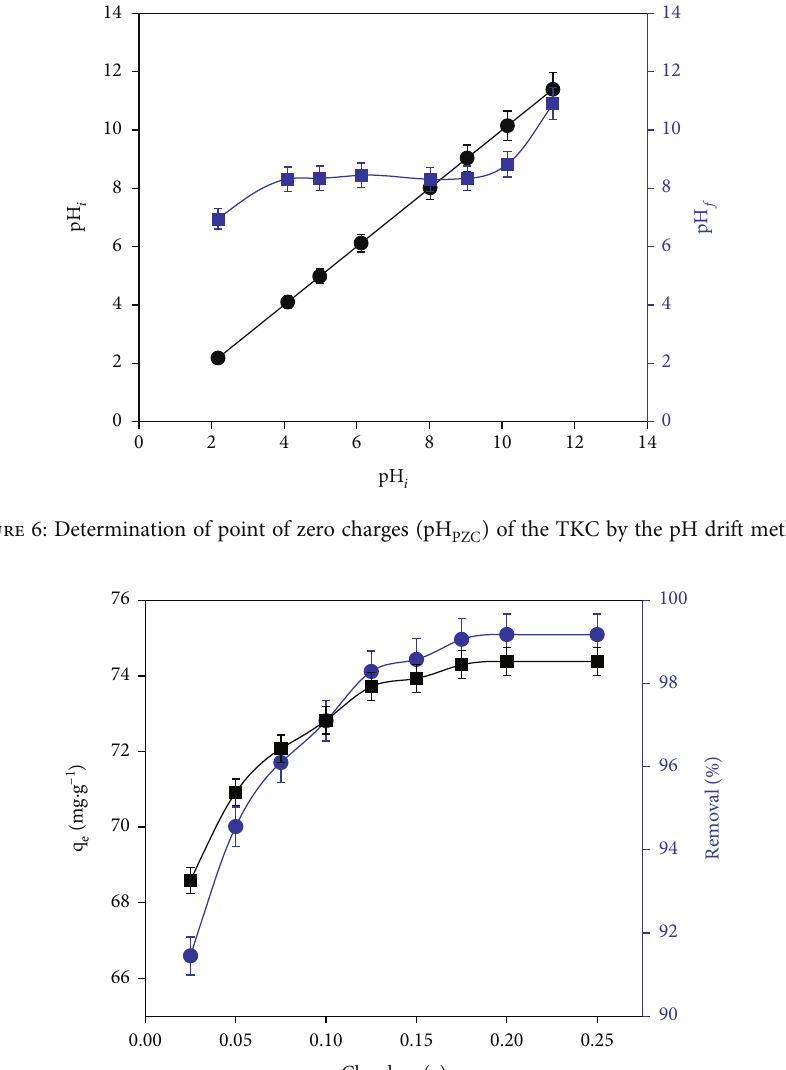
Figure 7: E ff ect of dosage on the adsorption of 150 mg · L -1 BF on TKC at 30 °